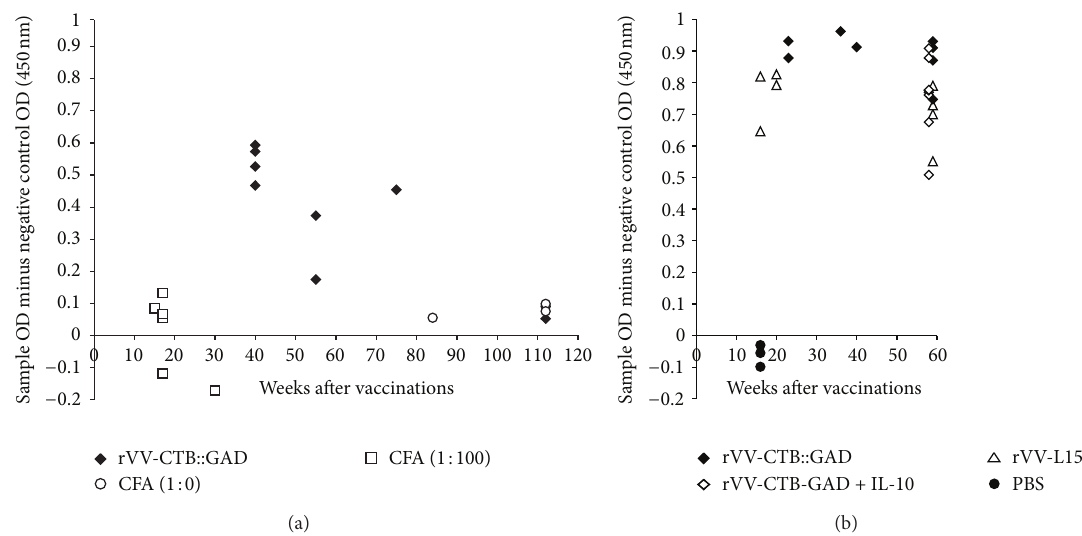
Figure7:Vacciniavirus-specifichumoralimmuneresponseinNODmice.((a)Exp.no.1and(b)Exp.no.2).DeterminationoftheVV-specific IgG was performed using indirect ELISA in two separate experiments. Naive (PBS), CFA (1:10), and CFA (1: 100) mice served as controls for absence of VV-specific antibodies, while rVV-L15-treated [10] mice were controls for autoantigen-expressing virus